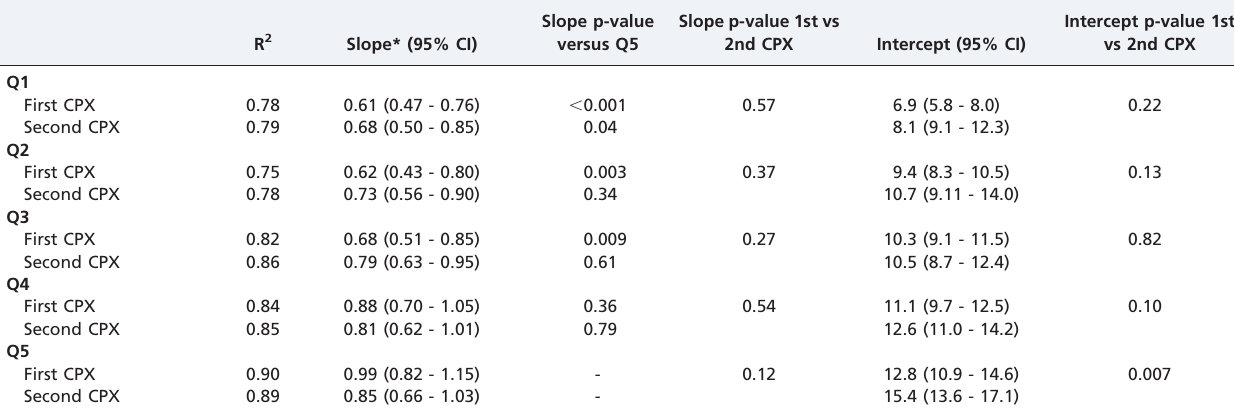
R 2 , coefficient of determination for correlation between Relative O 2 Pulse and CPX duration; CI, Confidence interval; Q, quintile. * Slopes significantly different from zero (p ,